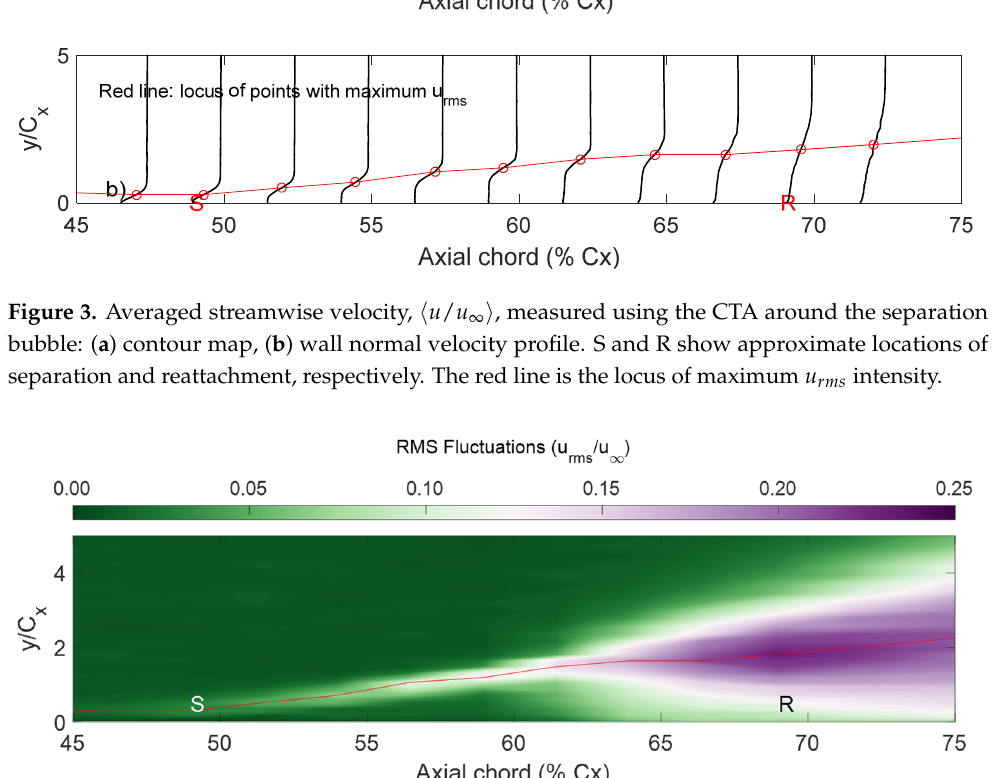
Table 1. Test section and inlet flow